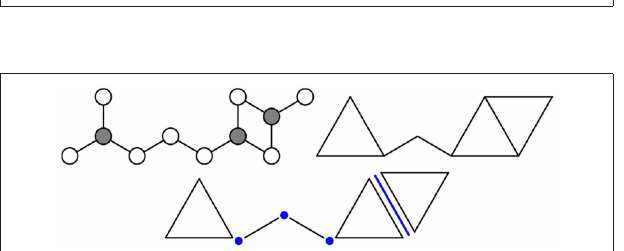
FIGURE 3 | A portion of an atomic network (Top left) contains 2- and 3-coordinated white and gray atoms, respectively. The same network can be modeled using rigid polytopes (Top right) , where the bonds around gray atoms are replaced by triangles and the remaining bonds by line segments. More precisely (Bottom) , the network is composed of five direct polytopes (two 1-polytopes and three 2-polytopes) and four intersection polytopes (three 0-polytopes and one 1-polytope).